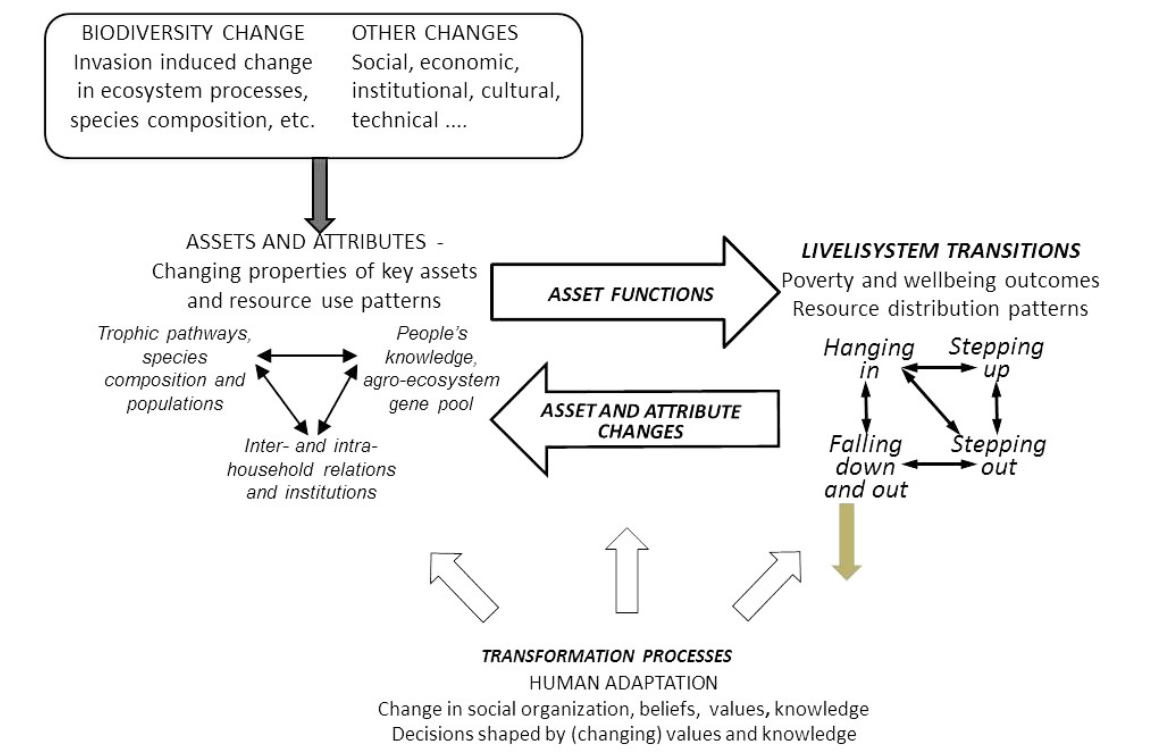
Fig. 2. Conceptual framework: human adaptation to biodiversity